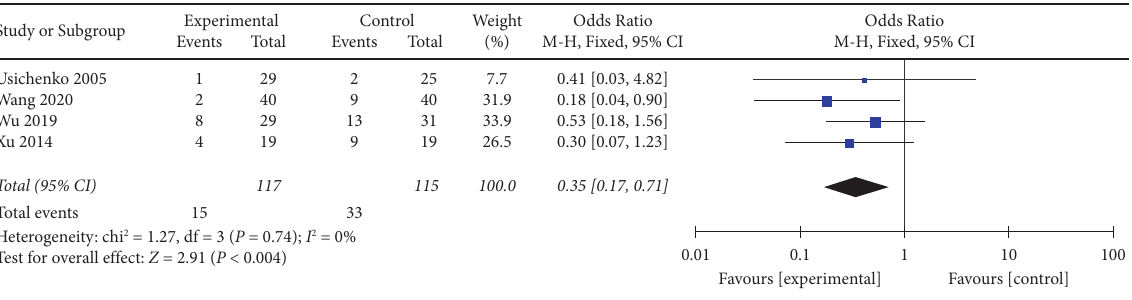
Figure 12: Comparison of the adverse events between the AA group and the control